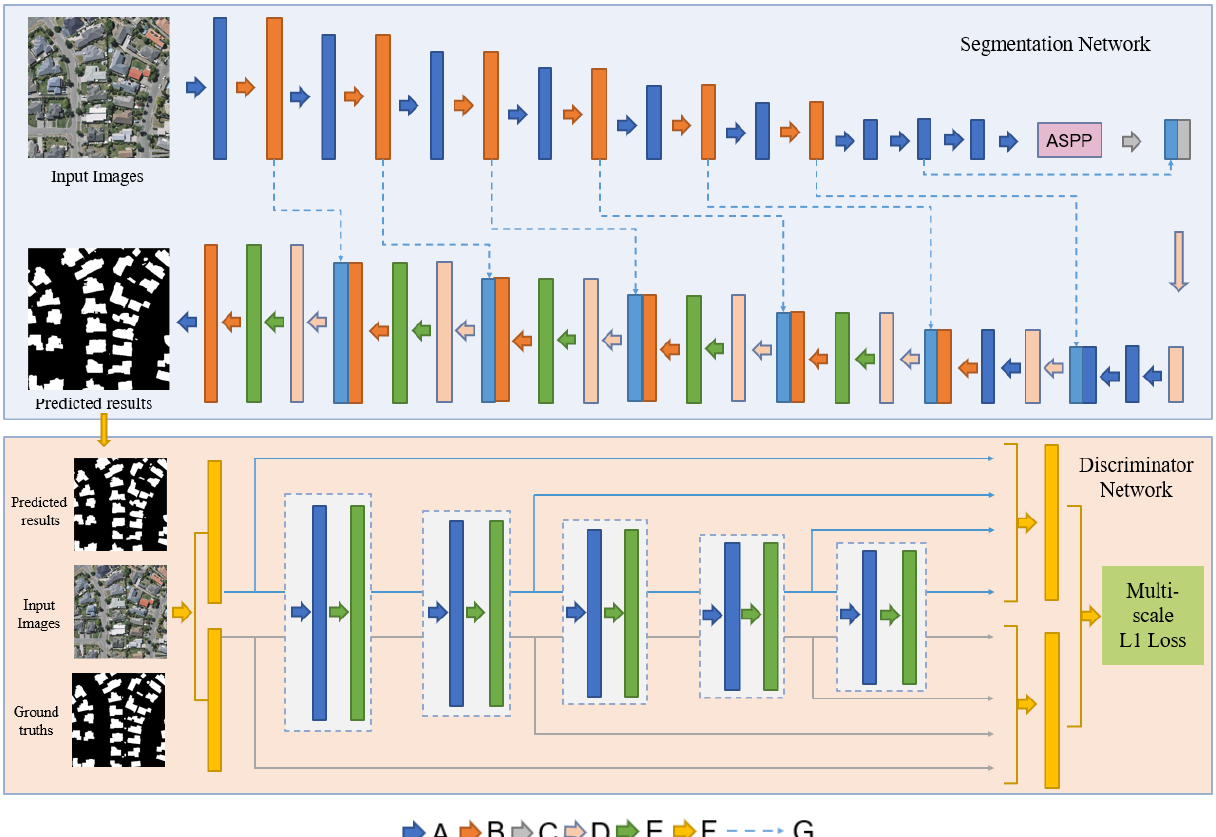
Figure 1. The structure of our proposed ASGASN. A are convolutional + batch normalization + Leaky rectified linear unit (Relu) layers; B is Residual block; ASPP is Atrous Spatial Pyramid Pooling; C is transposed convolution + batch normalization + Relu layers; D is upsample; E is Global convolutional block+ batch normalization+ Relu layers; F is concatenation operation; G is skip-connection.